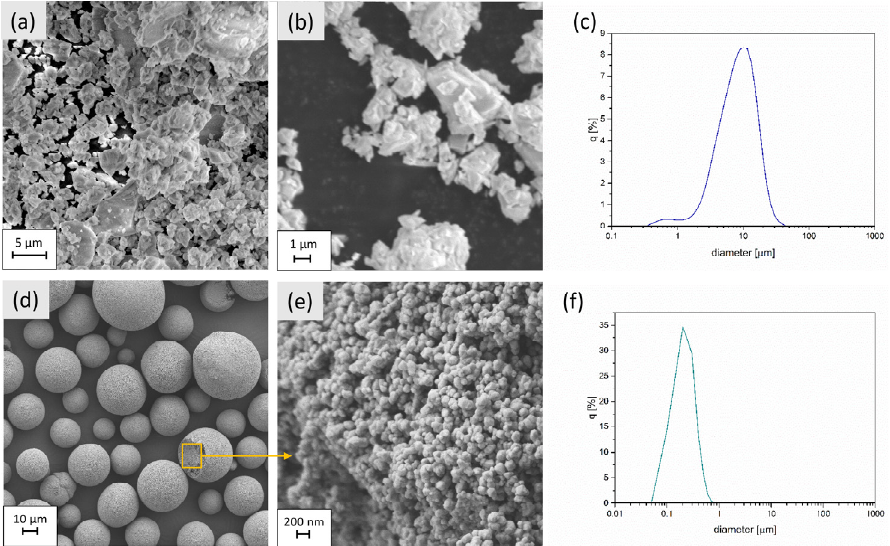
Figure 2. Microstructure and histogram of the grain size distribution of glass powder Schott GM31107 ( a – c ) and YSZ powder ( d – f ).